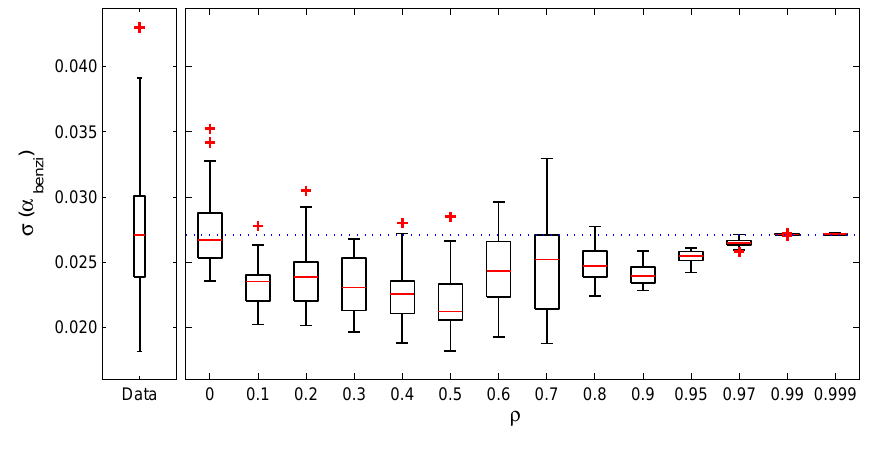
Fig. 14. Gradual wavelet reconstruction of the dataset giving the median value for σ(α benzi ) based on fifty realisations of the multifractal process is shown in the right-hand figure. The left-hand figure is a boxplot giving the inherent variability of σ(α benzi ) for the 50